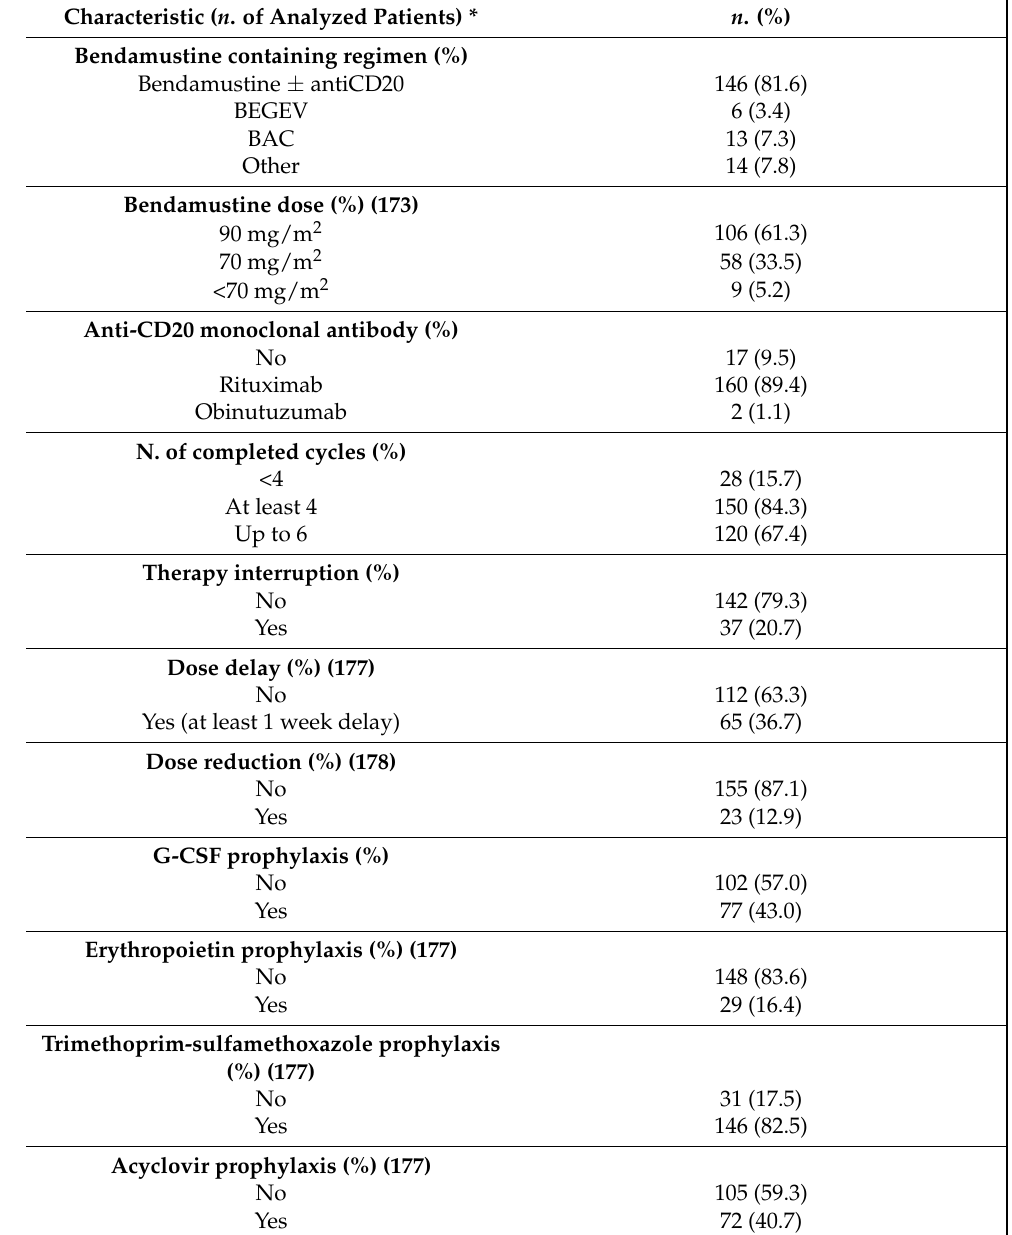
Table 2. Treatment features and supportive care. Characteristics of regimens, dose, duration, and concomitant medications for prophylaxis of treatment-related infections and cytopenias. Characteristic ( n . of Analyzed Patients) * n . (%) Bendamustine containing regimen (%) Bendamustine ± antiCD20 146